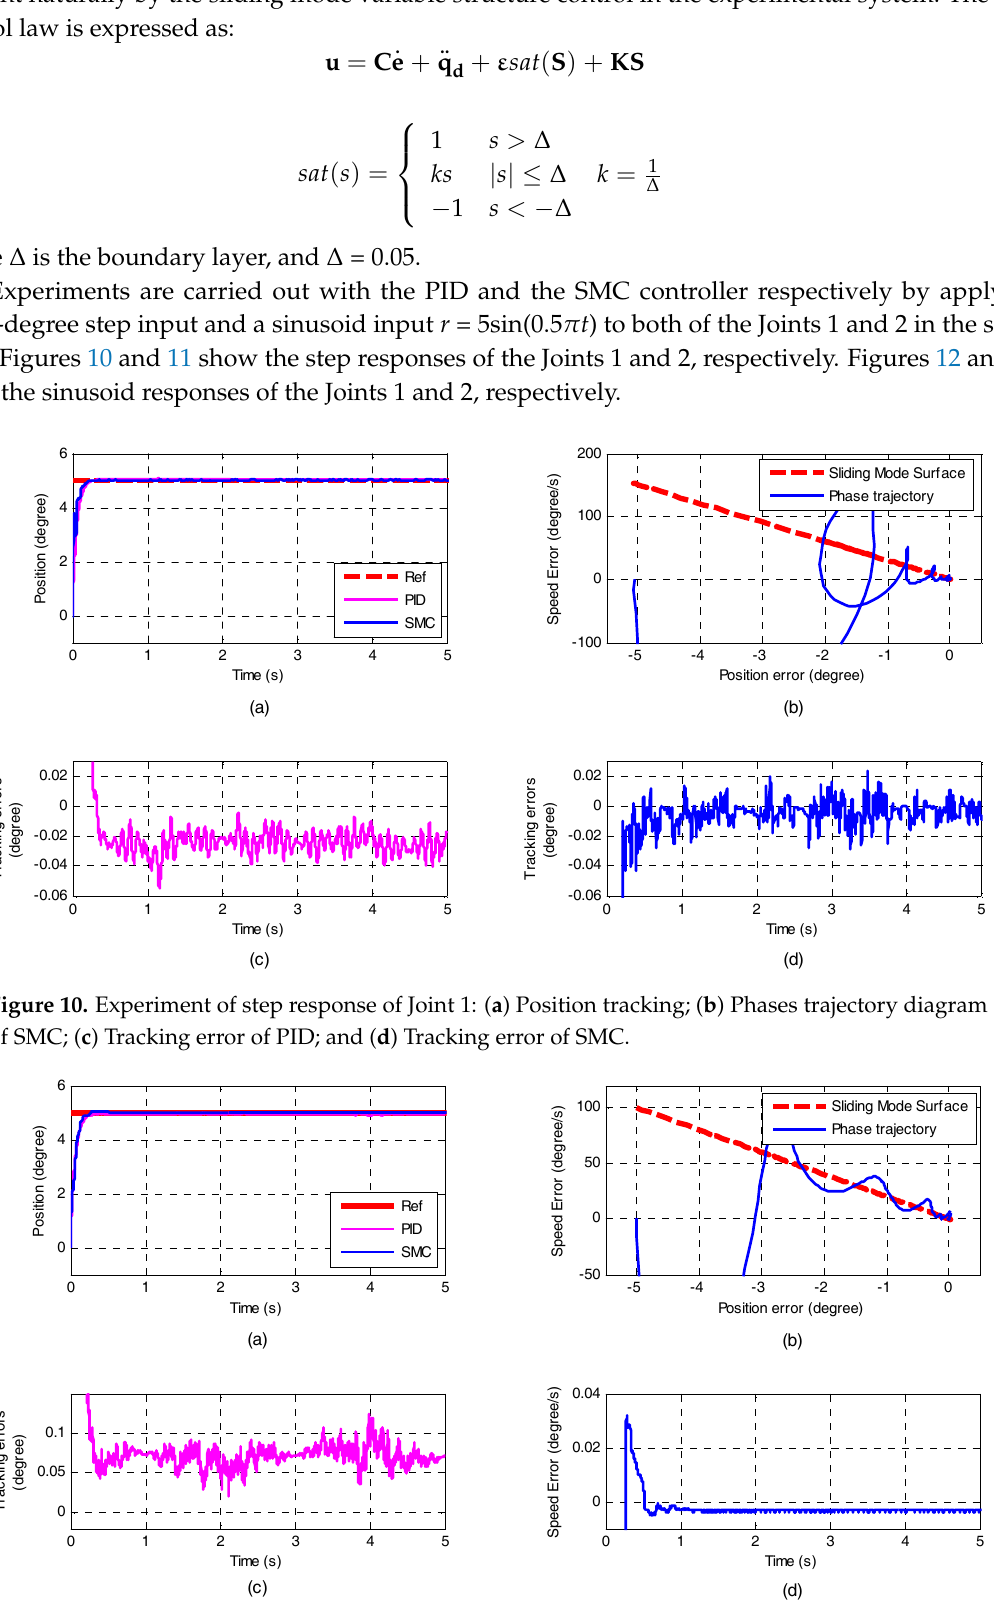
Figure 11. Experiment of step response of Joint 2: ( a ) Position tracking; ( b ) Phases trajectory diagram of SMC; ( c ) Tracking error of PID; and ( d ) Tracking error of SMC.